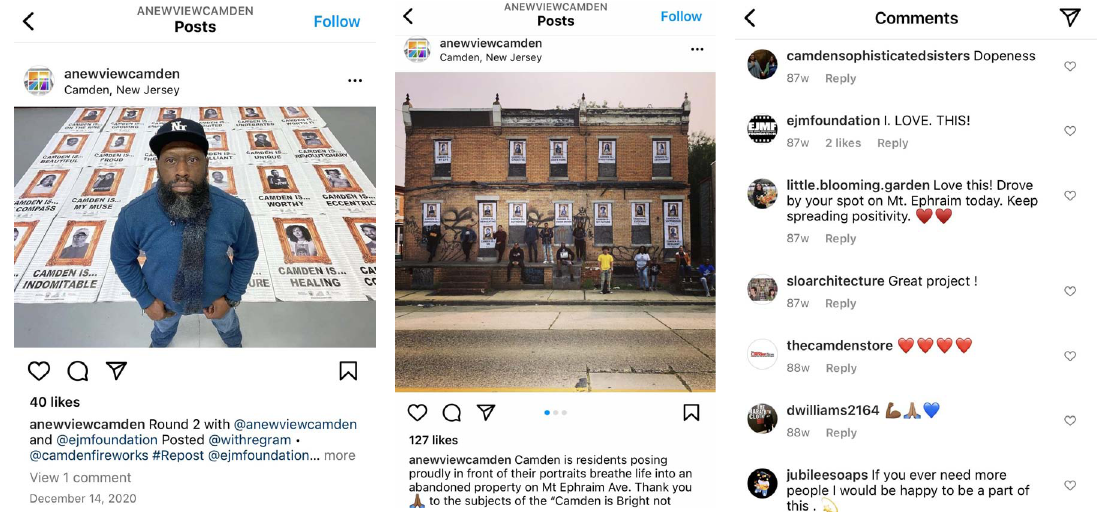
Figure 7. Instagram Post- Interactions with A New View through social media